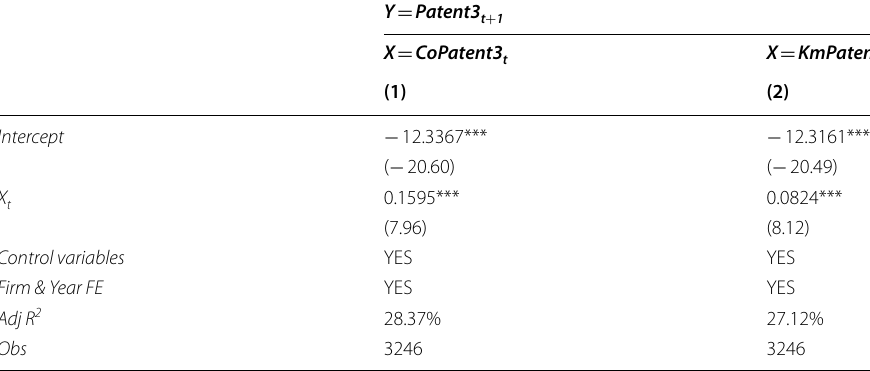
This table presents the regression results of the overall sample in regression (5). We have replaced RD1 for Patent3 . Column (1) and (2) respectively shows the regression results of two explanatory variables on the dependent variable. Firm fixed effects and year fixed effects are controlled in the regression. The T statistic is in parentheses under the coefficient. *, **, and *** mean statistical significance at 5%, 1%, and 0.1%